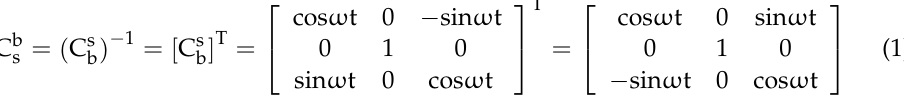
Figure 2. The b-frame and s-frame transformation diagram.